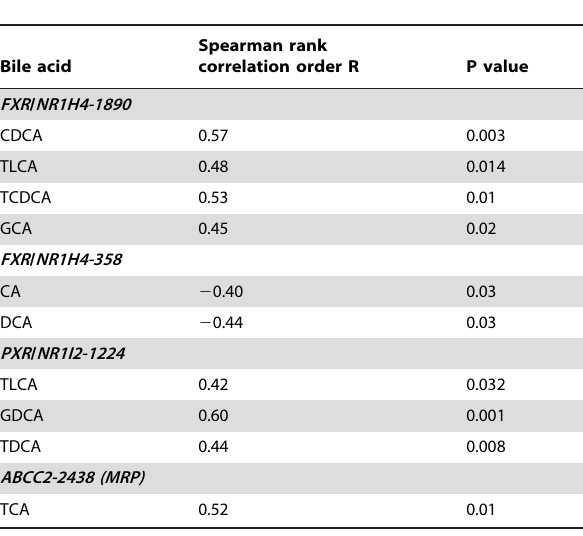
Table 3. Statistical analysis of the correlation between methylation levels at the promoter of candidate genes and bile acid